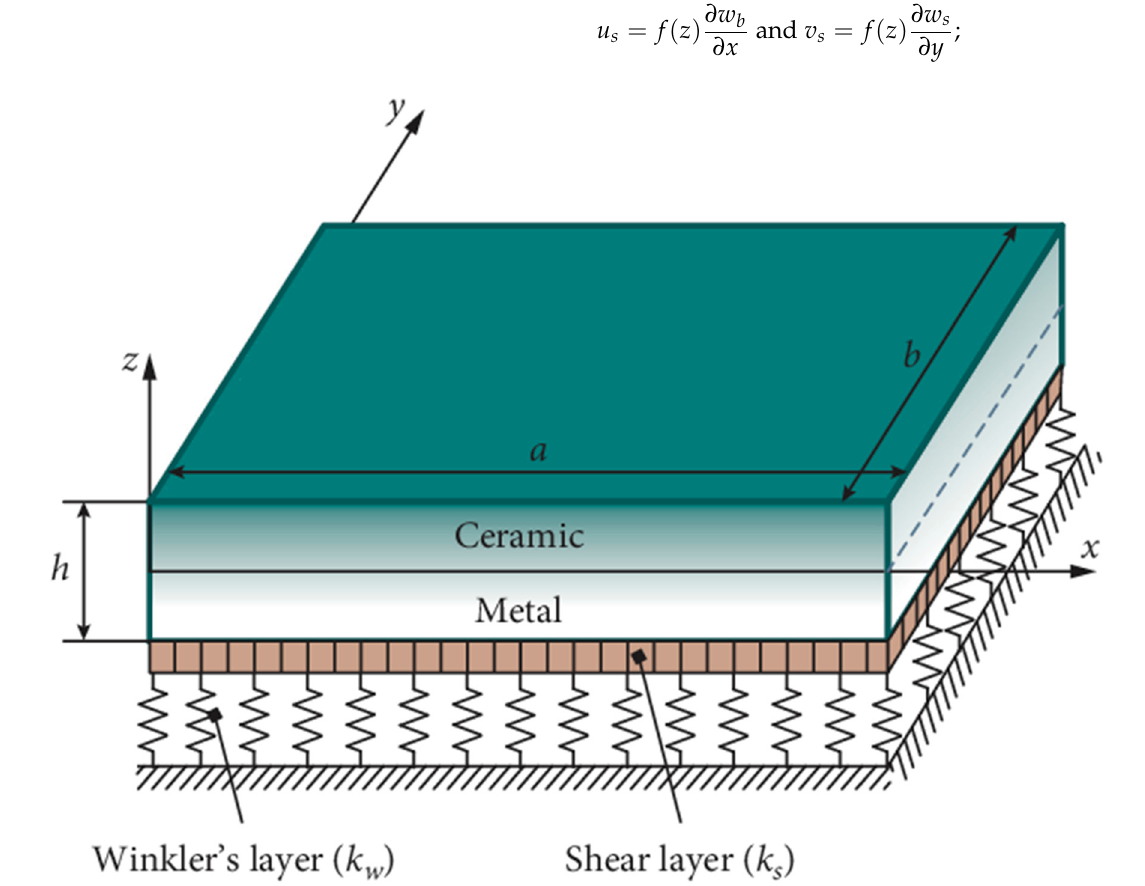
Figure 1. Geometry and coordinates of a rectangular plate supported by an elastic foundation.